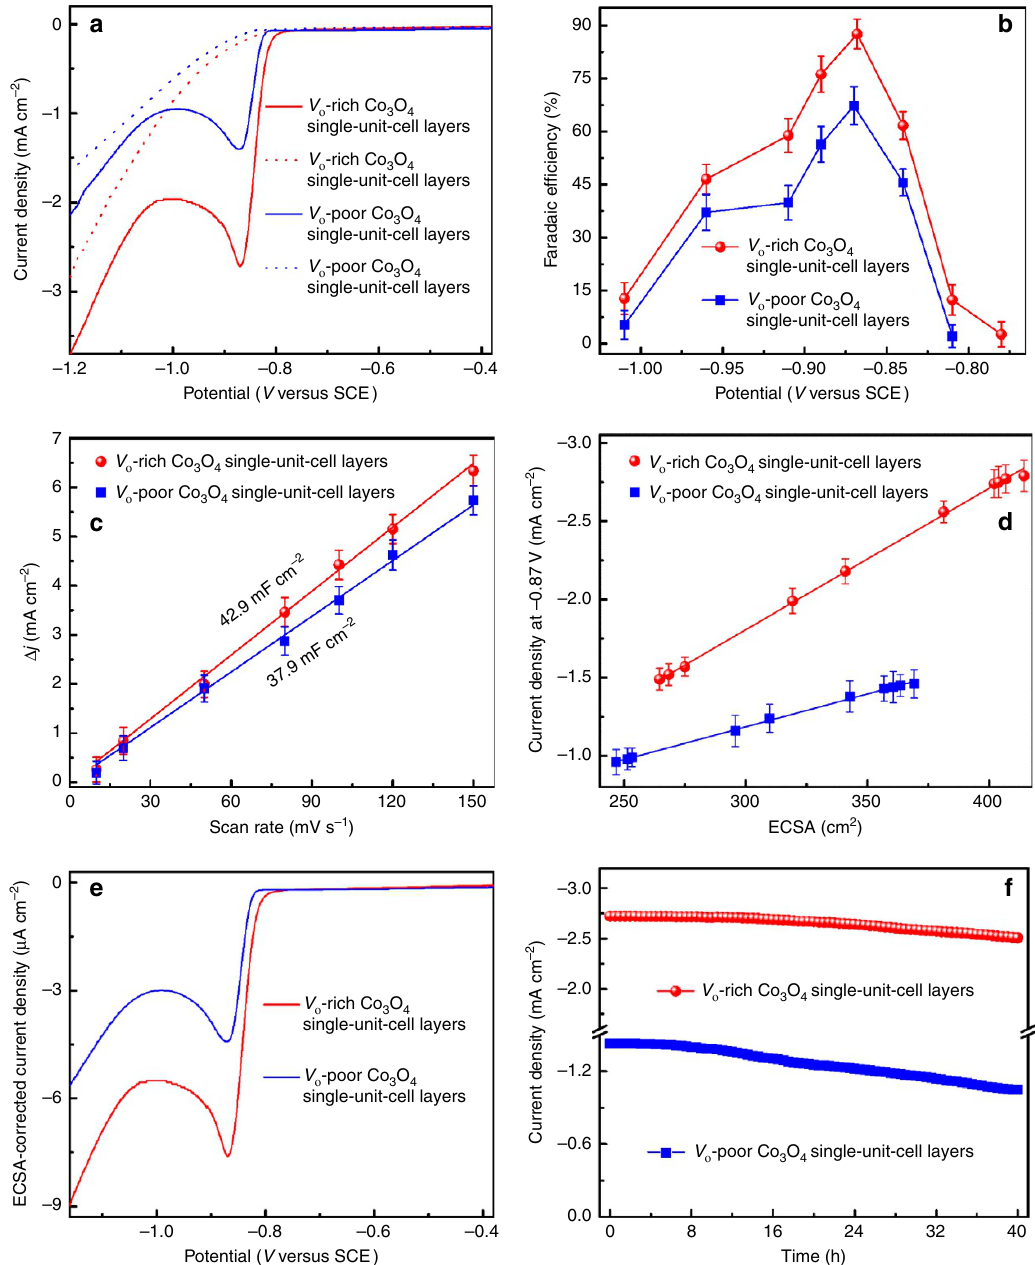
Figure 3 | Electrocatalytic reduction of CO 2 into formate by the V o -rich and V o -poor Co 3 O 4 single-unit-cell layers. ( a ) Linear sweep voltammetric curves in a CO 2 -saturated (solid line) and N 2 -saturated (dashed line) 0.1M KHCO 3 aqueous solution; ( b ) Faradaic efficiencies of formate at different applied potentials; ( c ) charging current density differences plotted against scan rates; ( d ) current density at (cid:2) 0.87V versus SCE plotted against ECSA for various material at different loadings; ( e ) ECSA-corrected current densities versus applied potentials; ( f ) Chronoamperometry results at the potential of (cid:2) 0.87V versus SCE. The error bars in b – d represent the s.d.’s of five independent measurements of the same sample.